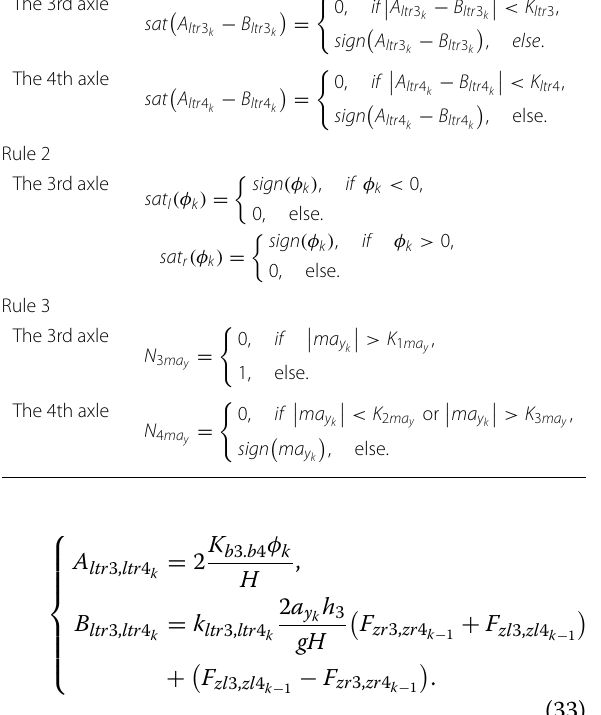
Table 2 Rules of the adjustments Rule 1 The 3rd axle